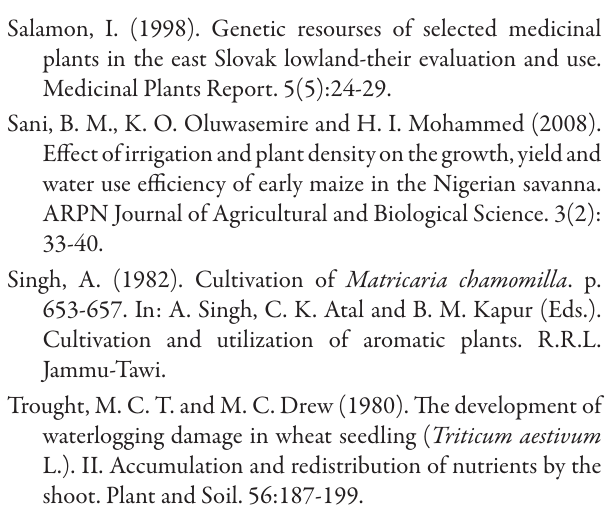
Fig. 3. Means of GDDs for flower and seed harvest under differ- ent irrigation regimes and plant densities. The same letters show non-significant